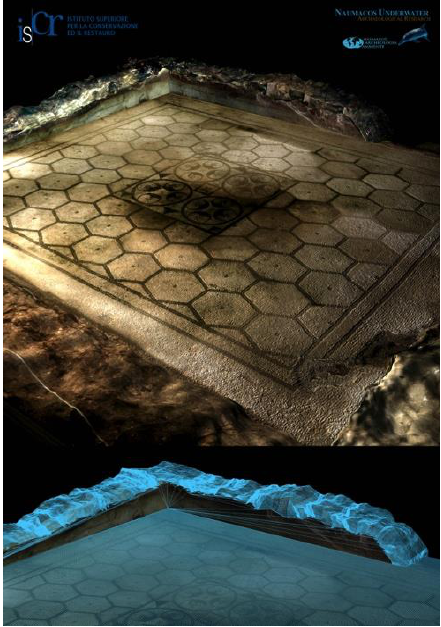
Fig. 9 - Laser Scanner relief of the bichrome mosaic with peltae.